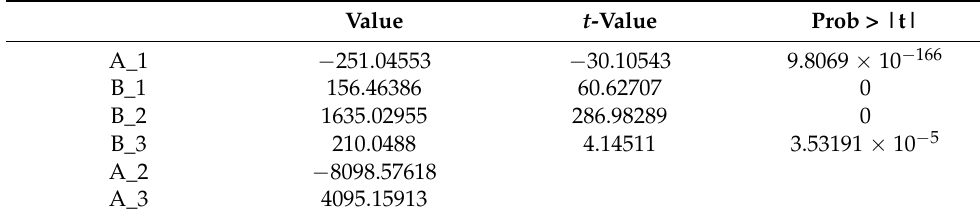
Table 6. Test parameters for significance of fitting curve (blue curve) of Figure